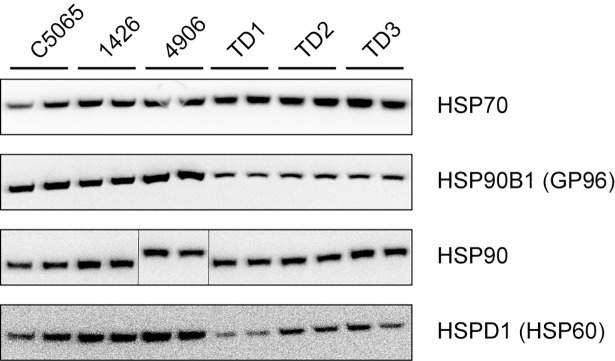
Expression of selected HSP proteins at basal level in DFTD cell lines and DFTD primary tumours.HSPs expression was detected by western blot using total protein isolated from three DFTD cell lines (C5065, 1426 and 4946) and three primary DFTD tumour biopsies (TD1, TD2 and TD3). The anti-HSP70 antibody detects different members of the HSP70 family; the anti GRP94 antibody detects the HSP90B1, the anti-HSP90 antibody detects various members of the HSP90 family and the anti-HSP60 detects the HSPD1. Bands represent two technical replicates for each biological sample. Bands from the same blot in the HSP90 panel were reorganised (vertical black lines) to have a consistent order in the figure. Original images of the blots are presented in S4 Fig. Results are representative of two experiments.